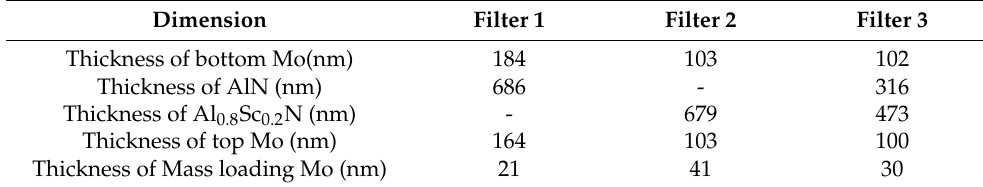
Figure 7. The proposed filter designs. ( a ) Schematic ladder circuit of the filter. ( b ) The comparison of simulated transmission responses among the filter 1 with AlN film, filter 2 with AlN/Al 0.8 Sc 0.2 N film, and filter 3 with Al 0.8 Sc 0.2 N film, respectively. Table 2. Structure parameters of the designed filters.